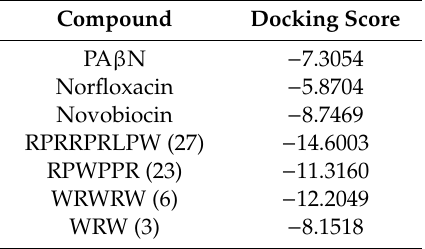
Figure 10. The most favorable pose of potentiating peptide 27 , RPRRPRLPW-NH 2 (green) establishes interactions with both the distal (yellow) and proximal (blue) binding pocket. Interactions can be observed with all four residues forming the loop (red) and in particular Arg6 (bold green) interacts with Phe617. Table 3. Docking scores obtained for the known efflux pump inhibitor PAβN, reference antibiotics novobiocin and norfloxacin, potentiating peptides 6 and 27 and non-potentiating peptide 3 .